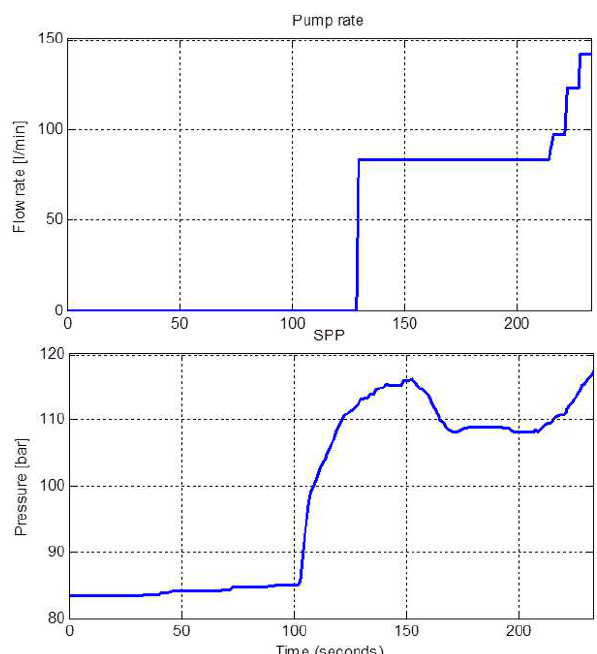
Figure 1: Measured flow rate and pump pressure when ramping up main pump. The pump started at the time when the increase in SPP started, but the pump rate signal was from strokes and therefore delayed.